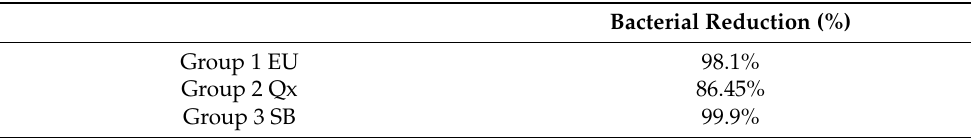
Table 2. Reduction rate of Enteroccus faecalis in CFU mL − 1 after